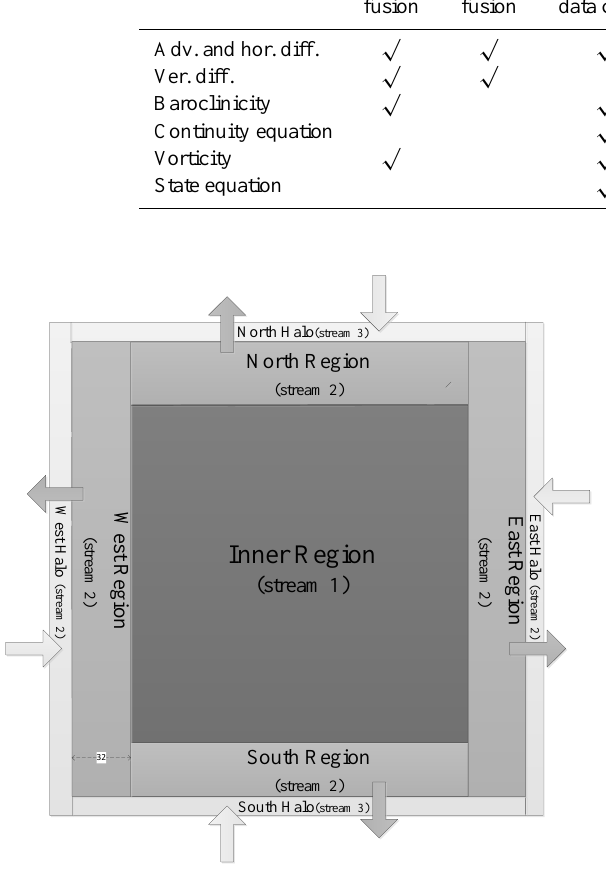
Figure 6. Data decomposition in the POM.gpu.